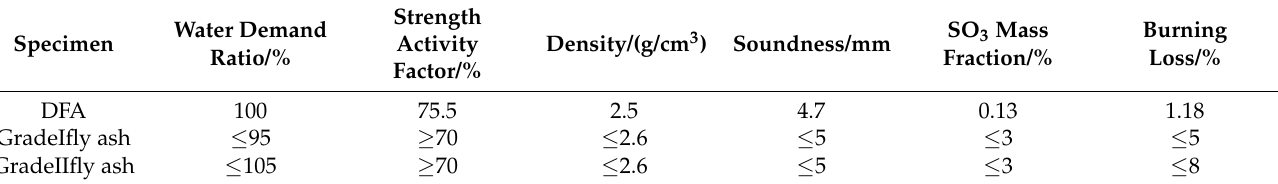
Table 5. Main properties of decarburized fly